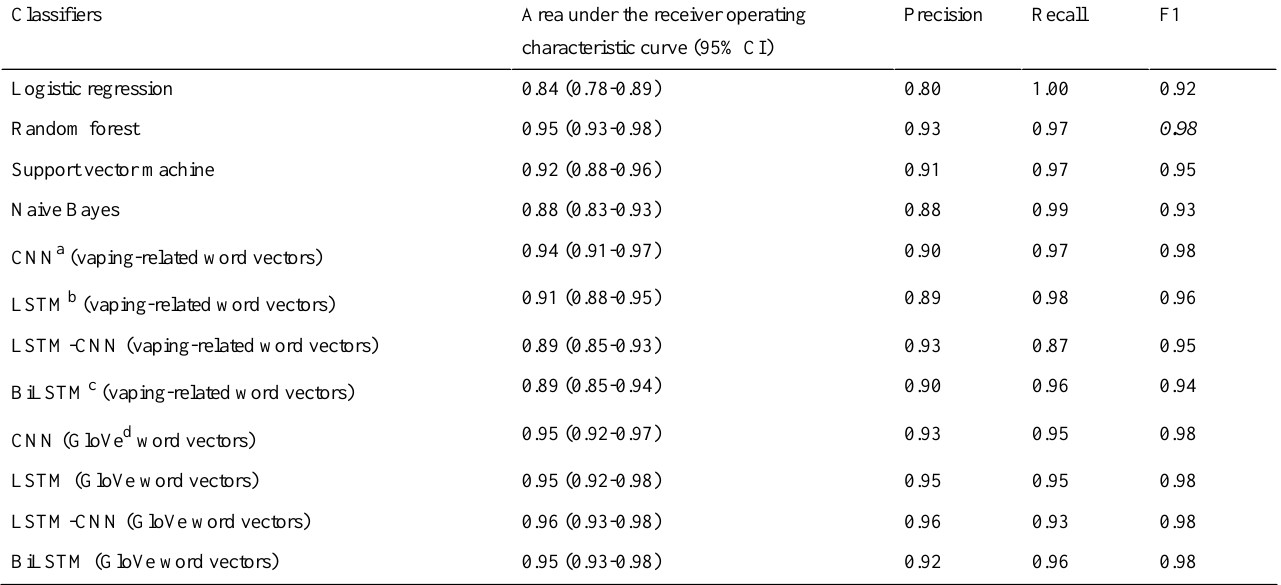
Table 6. Performance of relevance classifiers.